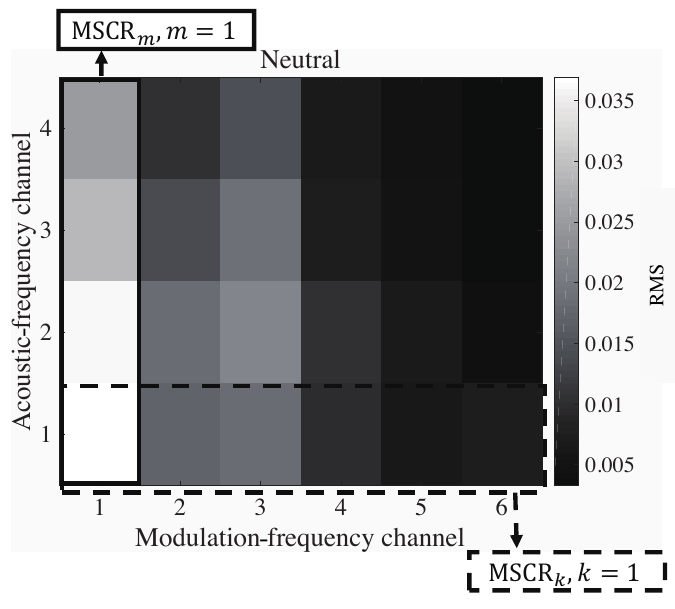
Figure 7. Calculation example of MSCR m and MSCR k